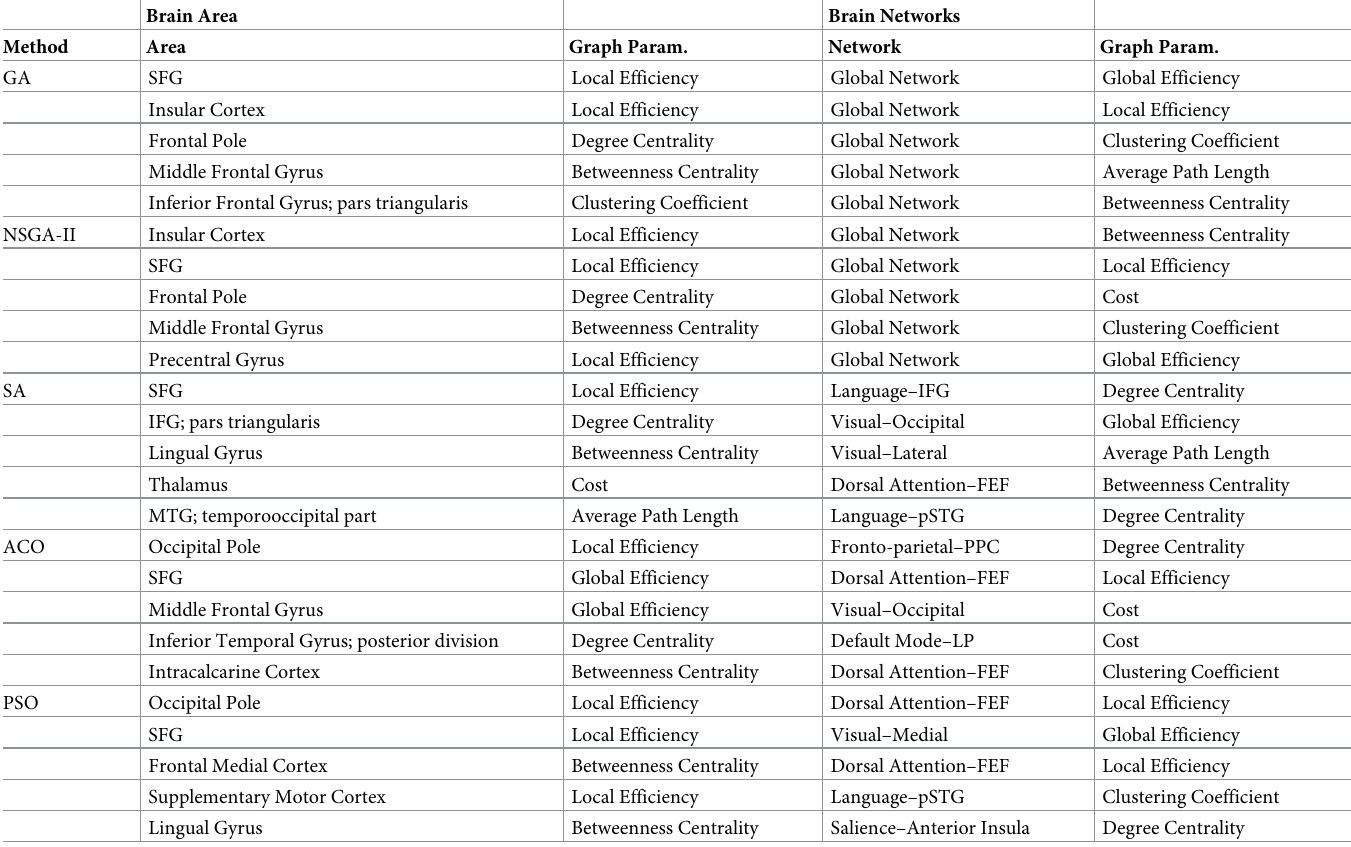
Table 2. Summary of the five most indicative brain areas and networks in the classification of healthy (HC) and early mild cognitive impairment